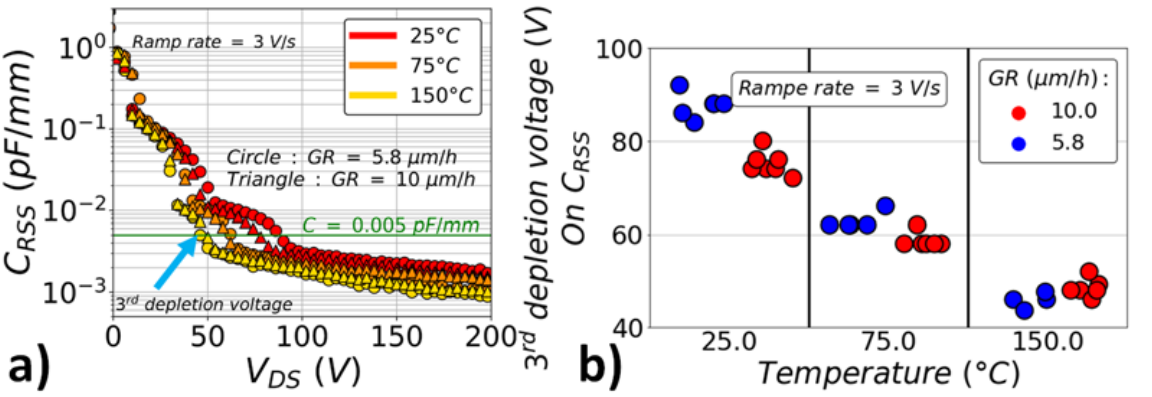
Figure 2. ( a ) Experimental C RSS (V DS ,T) at V GS = − 2 V. ( b ) Temperature dependence of the third depletion voltage as a function of the GaN:C epitaxial growth rate for several devices.